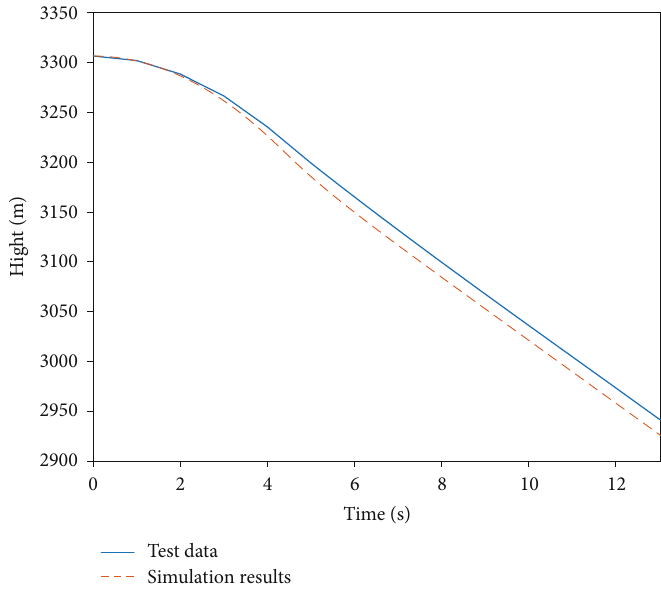
Figure 18: Height-time